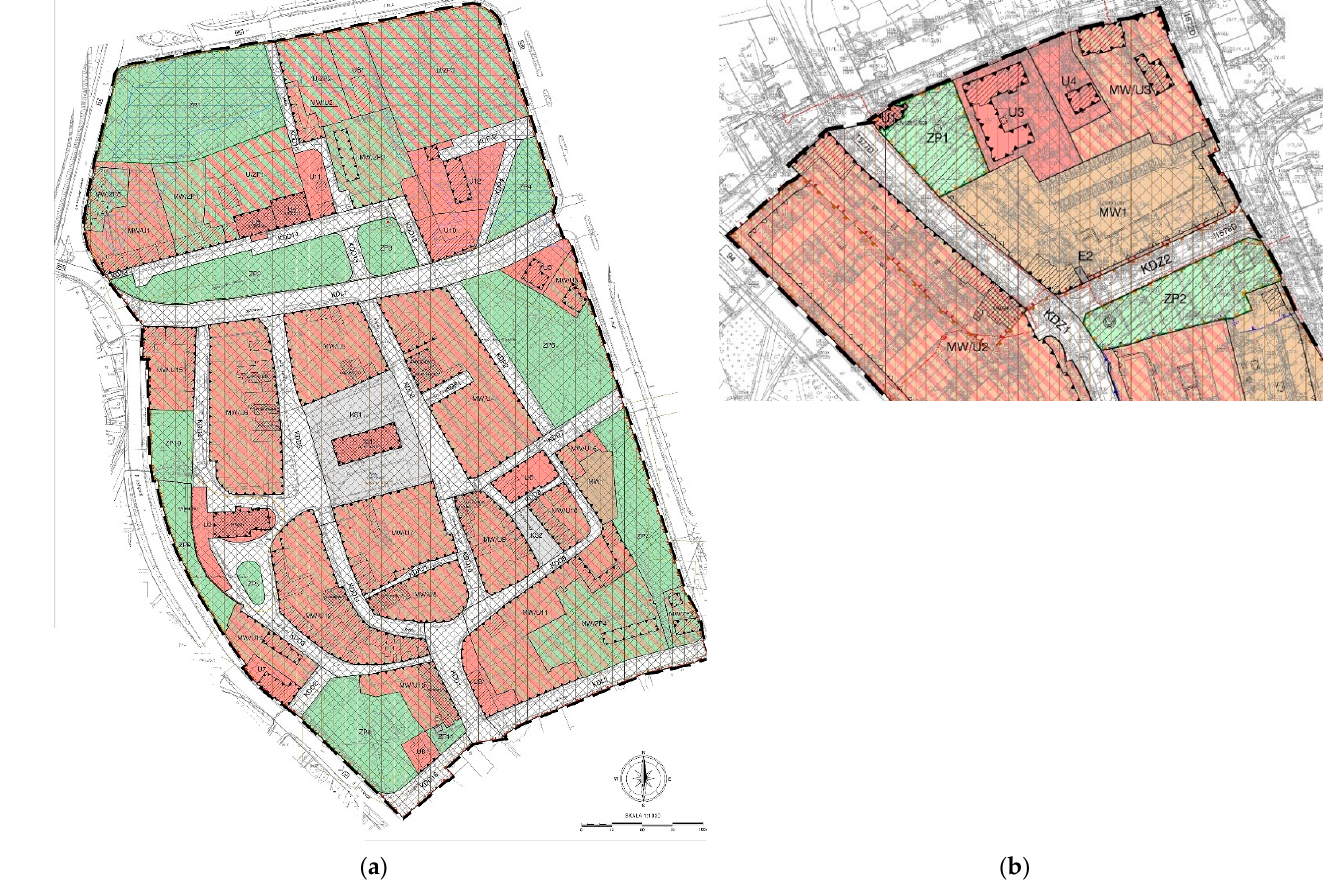
Figure 1. Arrangements of the local plan: ( a , b ) leaving the squares areas without the possibility of building development, maintaining the ring system of greenery in the city centre. The arrangements of the neighbouring areas include the function of greenery arranged for basic purpose, on par with the areas of multi-family housing and service buildings. Source: [27].